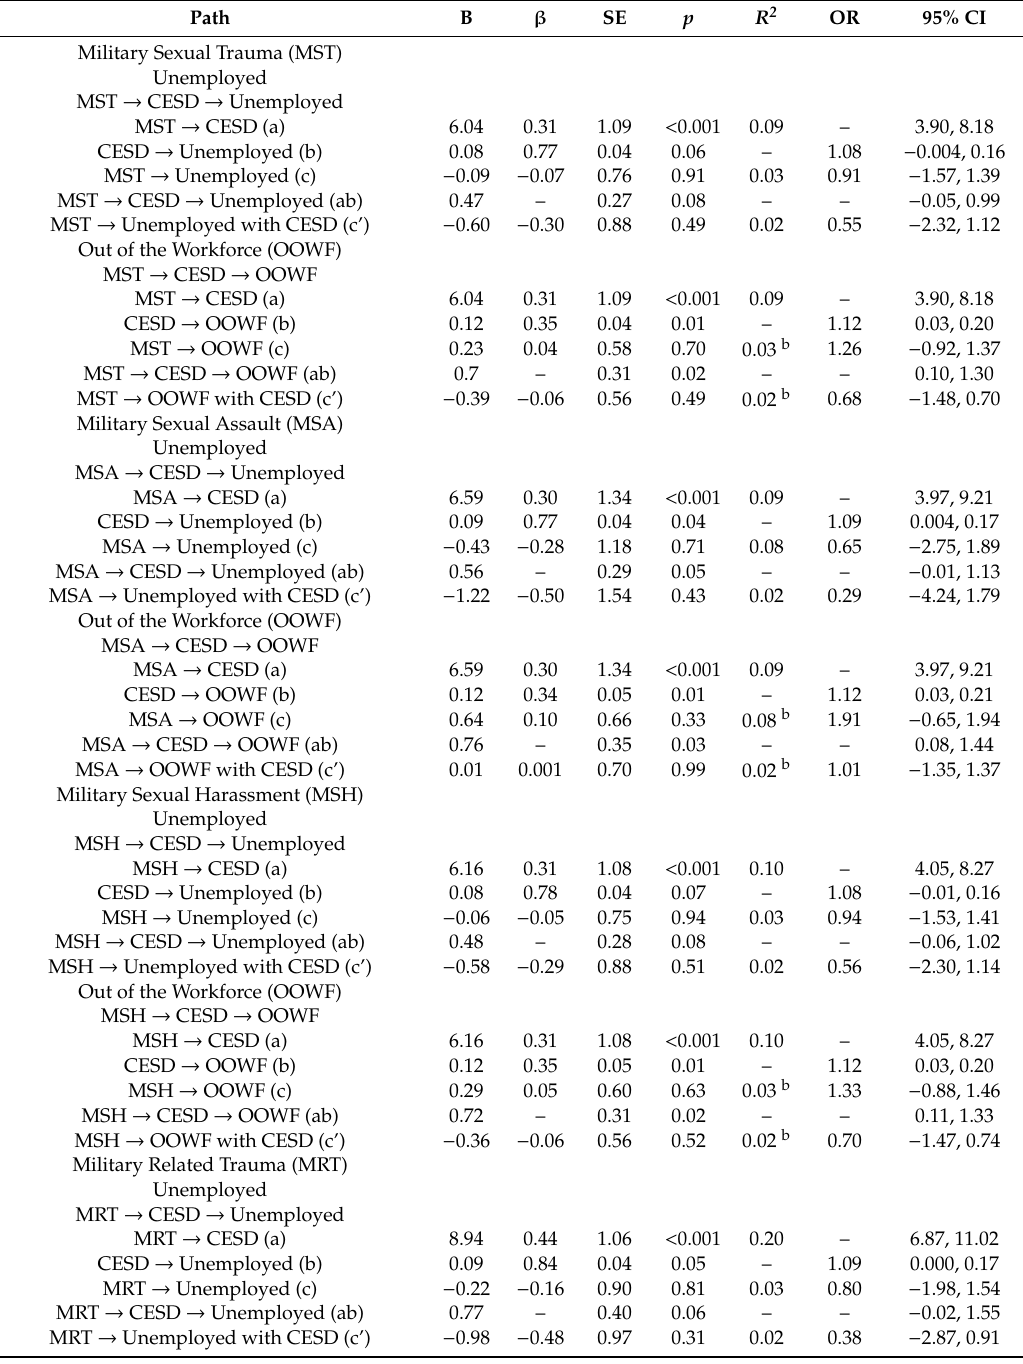
Table 3. Associations between trauma exposure and employment status, with depression symptoms as a